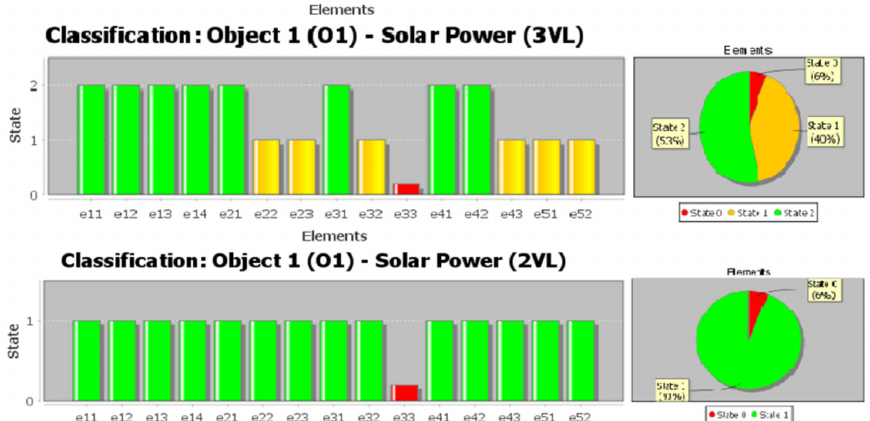
Figure 12. Screen of comparative analysis of the state assessment of L-PSPD in the DIAG 2